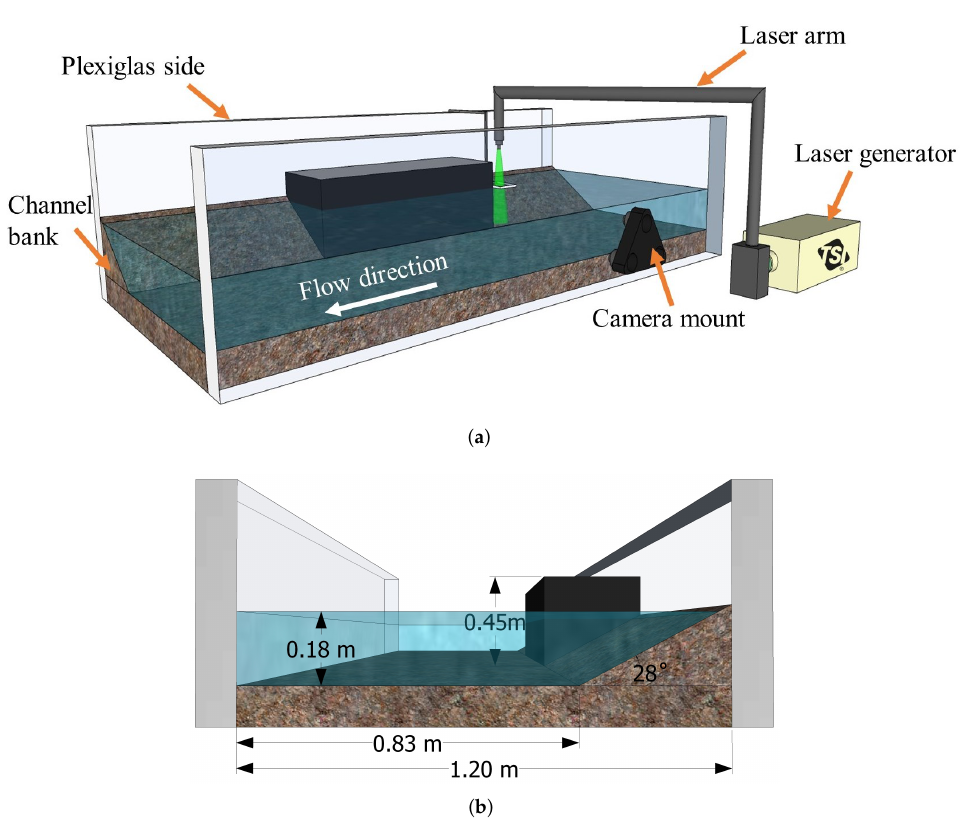
Figure 1. ( a ) A schematic of a section of the experimental flume along with the VPIV setup, ( b ) an upstream looking cross sectional view of the water recirculating